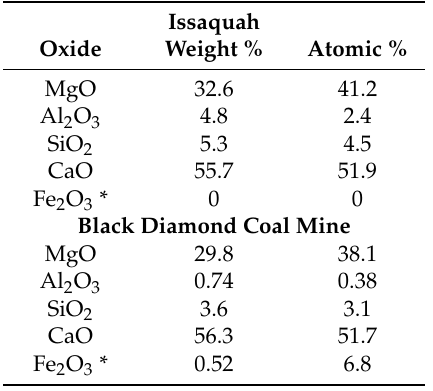
Table 2. Major element composition of dolomitized wood from Eocene Puget Group, King County, Washington, USA, determined by SEM/EDS.